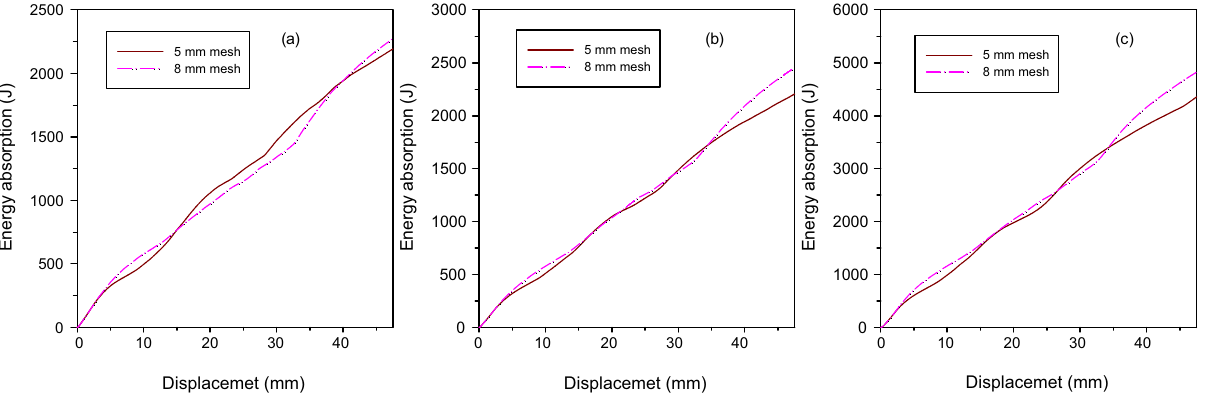
Figure 24: Energy absorption generated during loading from two mesh sizes with three di ff erent steel materials. ( a ) Mild steel, ( b ) SAE 1008 steel, and ( c ) SAE 1045